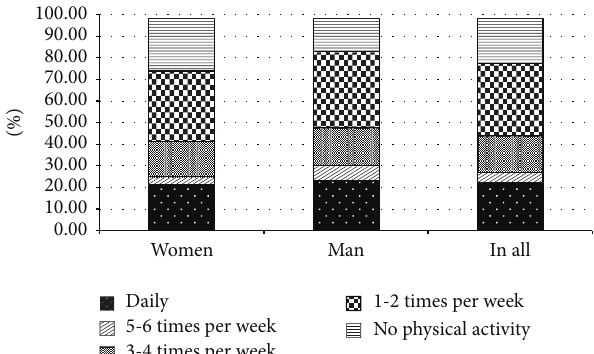
Figure 3: Frequency of any form of physical activity declared by study